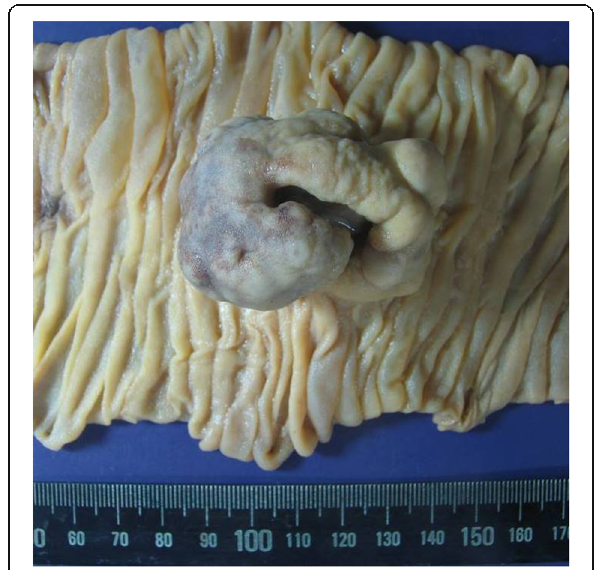
Fig. 4 Gross imaging of gastrointestinal stromal tumor